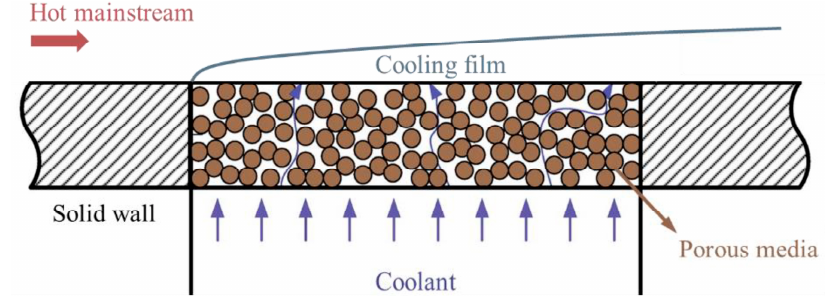
Figure 27. Schematic diagram of transpiration cooling principle.